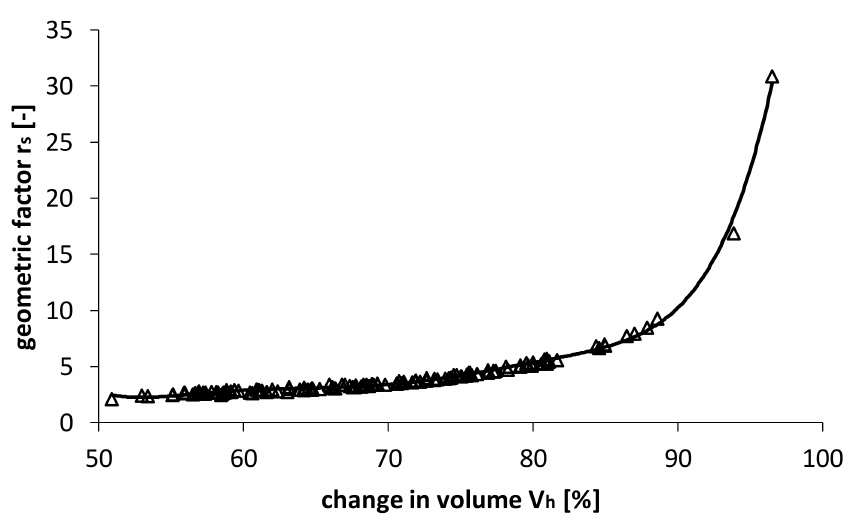
Figure 6. Relationship between the geometric factor and the horizontal component of volume